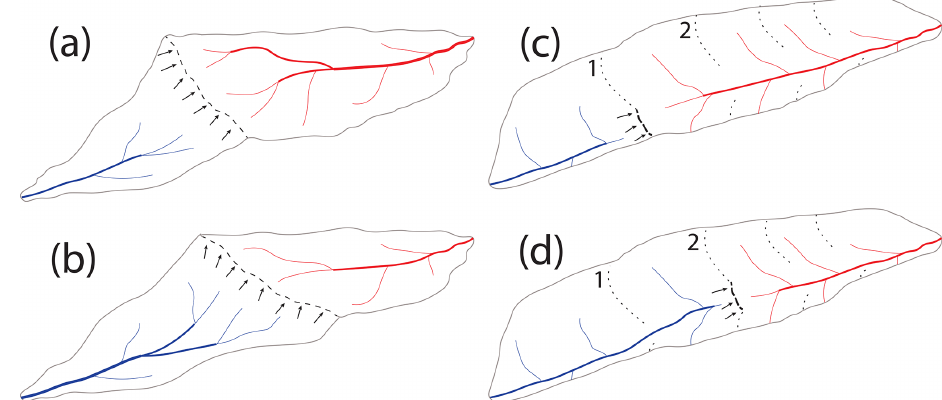
Figure 1. Schematic illustration of a typical (a, b) vs. along-valley (c, d) divide migration. (a) Illustration of a typical divide migration process with the divide (dashed line) located along a ridgeline (after Whipple et al., 2017). (b) The same setting as in panel (a) after the divide migrated some distance. Note that as the ridgeline migrates it erases the tributaries of the shrinking basin. (c) Illustration of a wind-gap (dashed line) migration along a valley. Note that the tributaries that drain to the valley can be preserved through the migration process so that the migrating wind gap can traverse confluences with tributaries through its migration. (d) Same setting as in panel (c) after the wind gap migrated some distance. Low-order channels are marked with thinner lines. Note that the low-order drainage divides between tributaries (dotted lines) can merge with the migrating wind gap to form a high-order divide (for example, see the low-order divides marked 1 and 2 in panels c and d